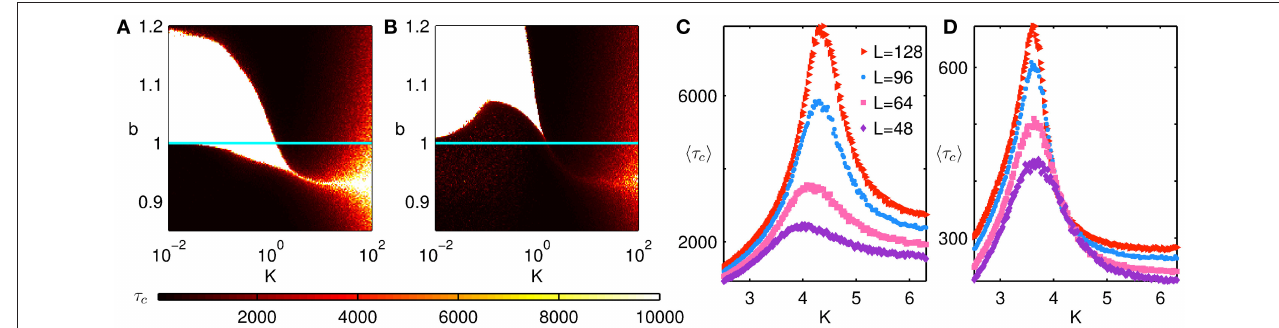
FIGURE 4 | (A,B) Convergence time τ c for agents on a network of size N 128 2 and average degree k avg 8, for rewiring parameters (A) p 0 and (B) p 1. The = = = = blue horizontal line corresponds to b 1, and demarcates the SH ( b < 1) and PD ( b > 1) regimes. Darker colors indicate a more rapid convergence to any one of the = absorbing states (viz., all C or all D ). We note that when K 1, larger values of τ c are obtained. This is because at high noise intensity (high K ), the system takes a ≫ long time to converge to an absorbing state. The regions marked as white in the high K regime correspond to the system not converging to the steady state within the duration of the simulation (10 4 time steps). On the other hand, the white regions seen for lower K ( . 1) correspond to the system persisting in a steady state, viz., the τ c fluctuating regime. These two qualitatively different white regions can be differentiated by the sharpness of their boundaries. (C,D) The average convergence time h i as a function of K for the case (C) p 0, b 0.94 and (D) p 1, b 0.98. The results are averaged over 10 3 trials, and shown for different system sizes. The = = = = situations displayed correspond to the transition between the all D and all C regimes. We observe that the convergence time at the interface of the two regimes diverges as the system size is